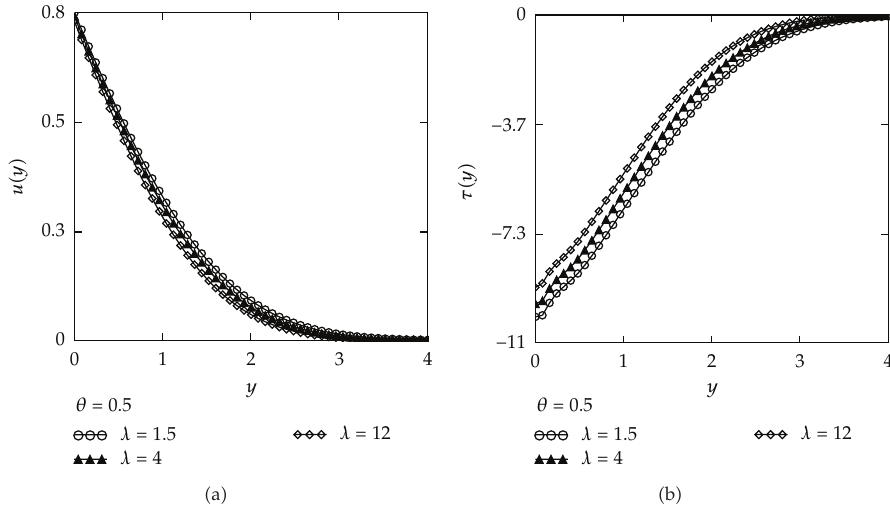
Figure 5: Profiles of the velocity field u (cid:4) y,t (cid:5) and the shear stress τ (cid:4) y,t (cid:5) for fractional Maxwell fluid given by (cid:4) 4.7 (cid:5) and (cid:4) 4.15 (cid:5) , for U (cid:9) 1, y (cid:9) 1, ν (cid:9) 0 . 379, μ (cid:9) 33, α (cid:9) 0 . 2, θ (cid:9) 0 . 5, t (cid:9) 5s, and di ff erent values of λ